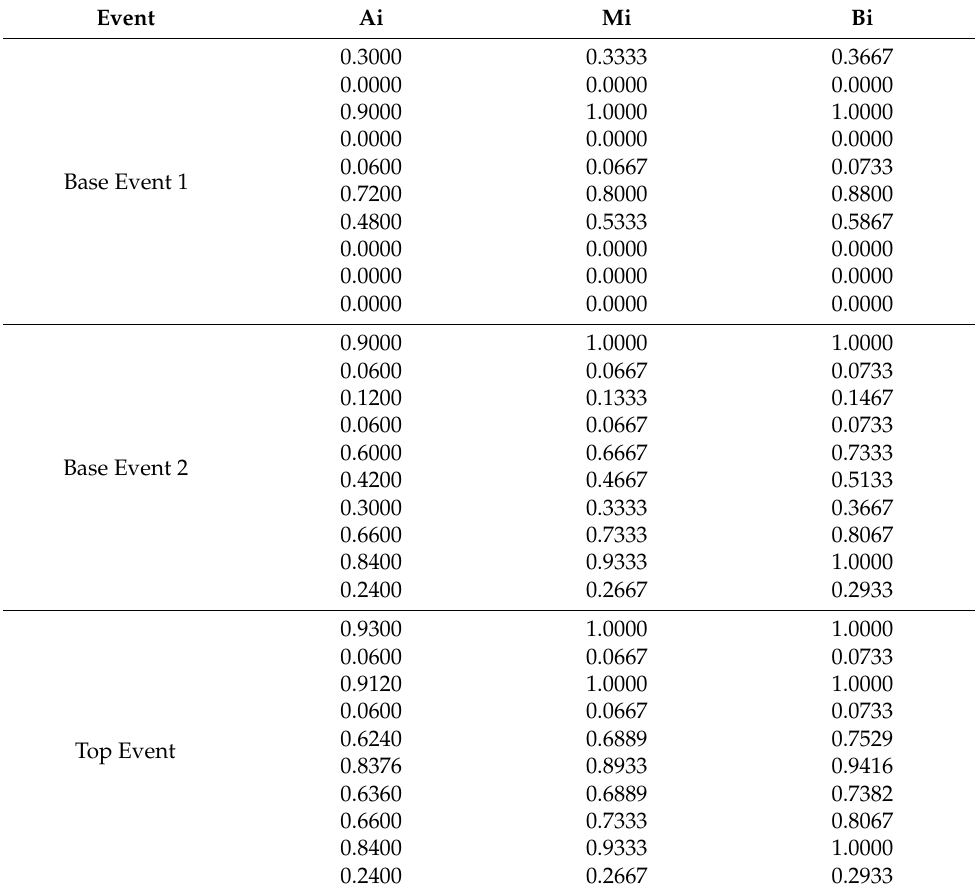
Table 2. Trigonometric fuzzy number of event probability in FFTA.